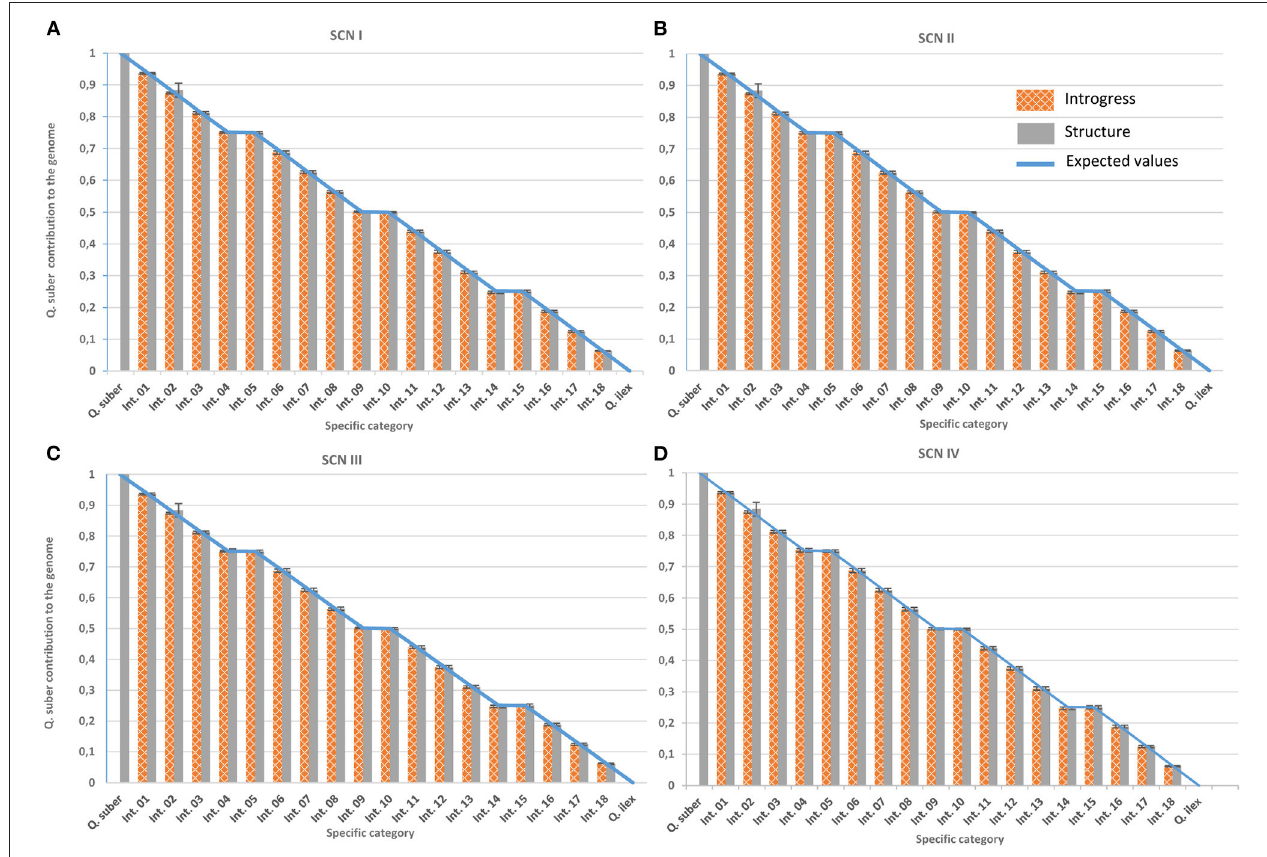
FIGURE 6 | Performance of classification tools under the different imputation scenarios. Genomic contribution of Q. suber is estimated using STRUCTURE ’s q s (plain grey) and INTROGRESS hybrid index (gridded orange) on virtual individuals generated with SimHyb (pure species and 18 intermediate categories). Expected values are represented by a blue line. Standard deviations are also indicated. (A) imputation scenario I; (B) imputation scenario II; (C) imputation scenario III; (D) imputation scenario